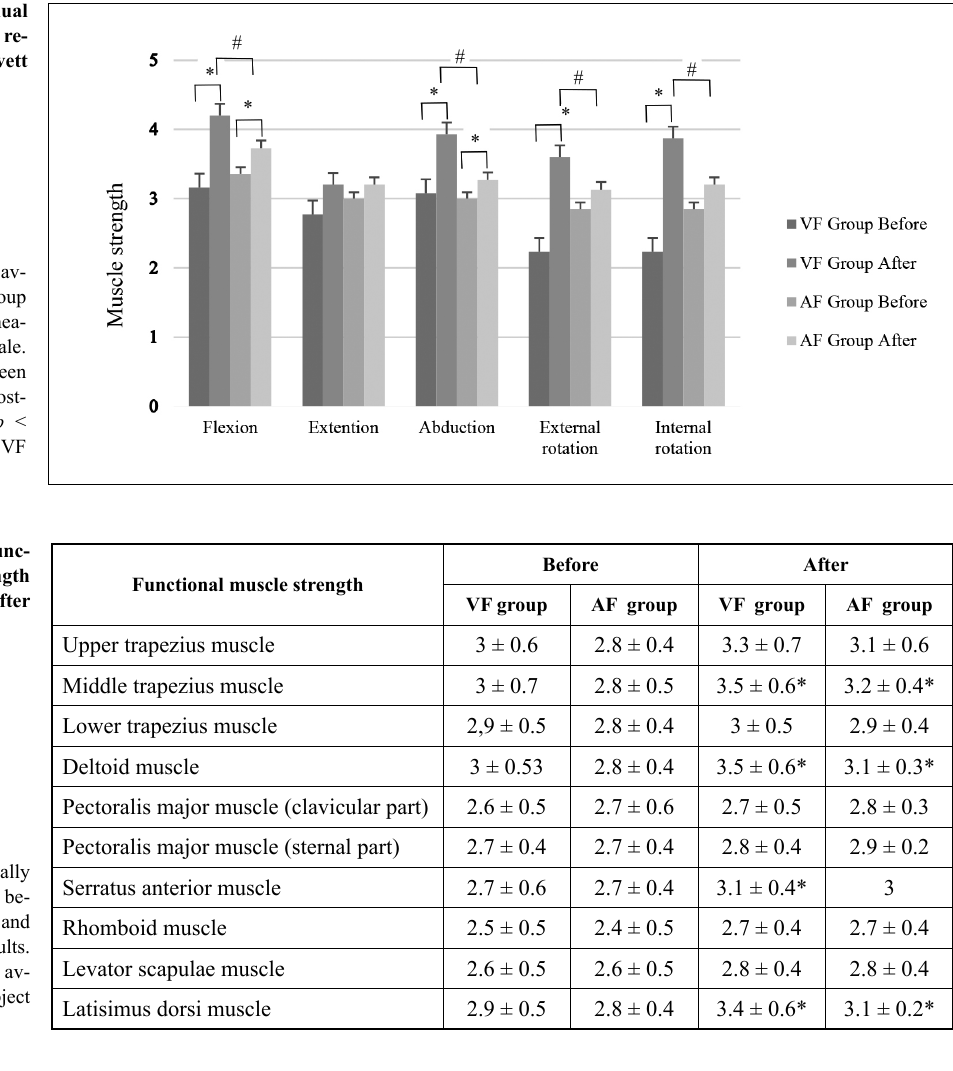
Table 3. Quality of life evaluation in each SF-36 questionnaire subscale